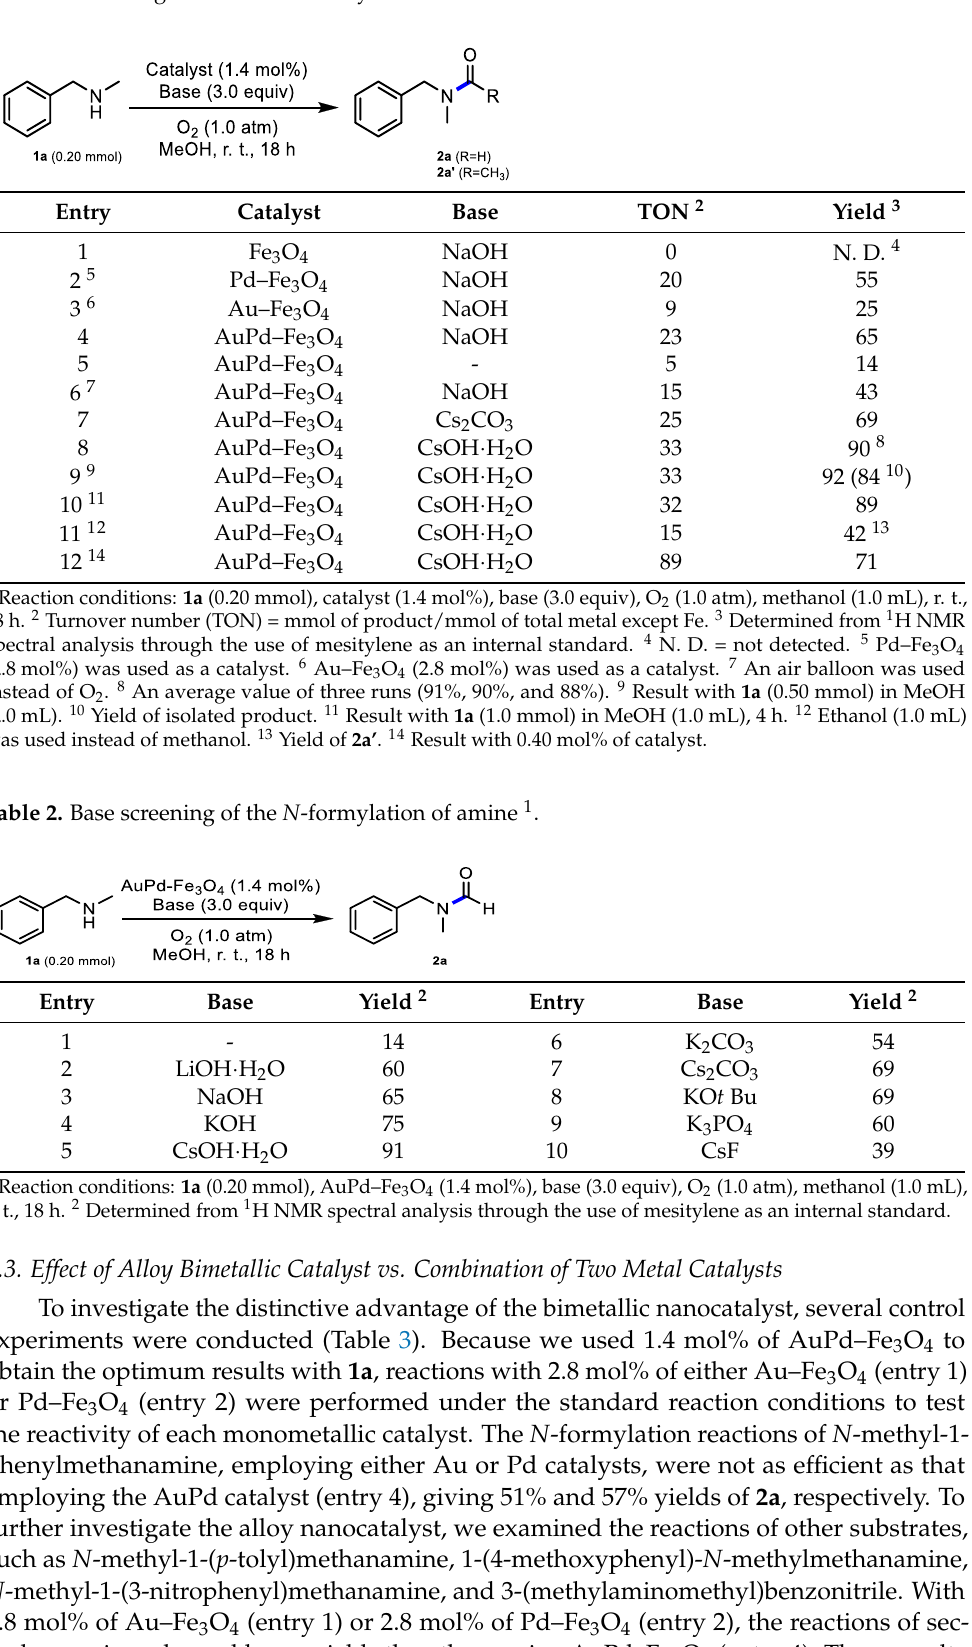
Table 1. Screening data of the N -formylation of amine 1 .